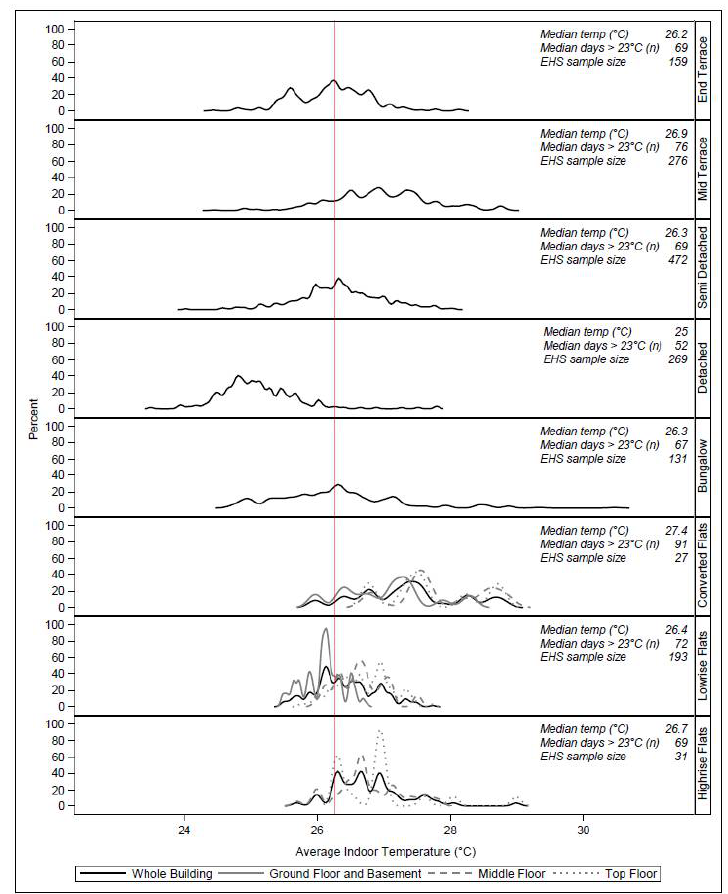
Figure 1. Density plots of the average indoor temperature when (cid:1846) (cid:3040)(cid:3028)(cid:3051),(cid:3042)(cid:3048)(cid:3047),(cid:3031) exceeds 23 °C during the 2030 summer. The red vertical line shows the median for the stock. There is a lack of data for ground- floor high-rise flats, and so these are not shown. English Housing Survey